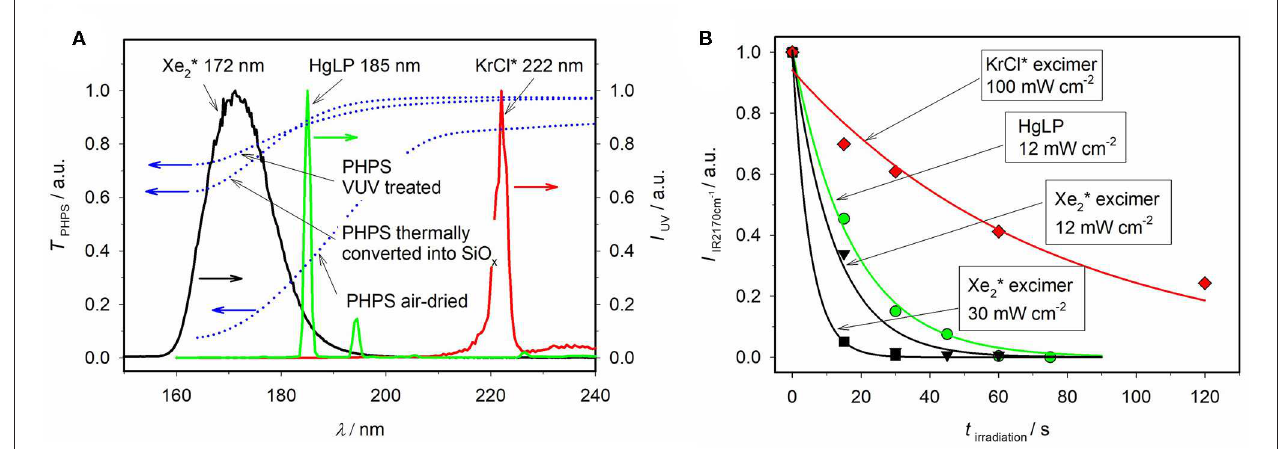
FIGURE 5 | (A) Measured UV-absorption spectra of precursor thin films and excimer-lamp emission spectra. (B) Kinetic evaluation of the intensity of the vibration band of the Si—H bond at 2170 cm − 1 , adapted from Prager et al.